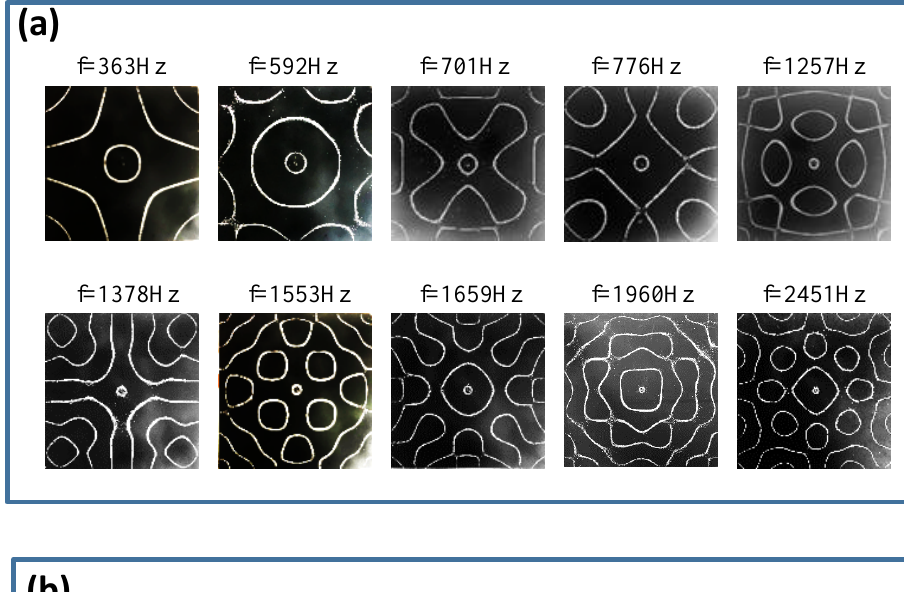
Figure 5. ( a ) Experimental nodal-line patterns for fixing the plate at r s = ( 0.5 L , 0.5 L ) (on the center). ( b ) Numerical nodal-line patterns corresponding to the experimental results.